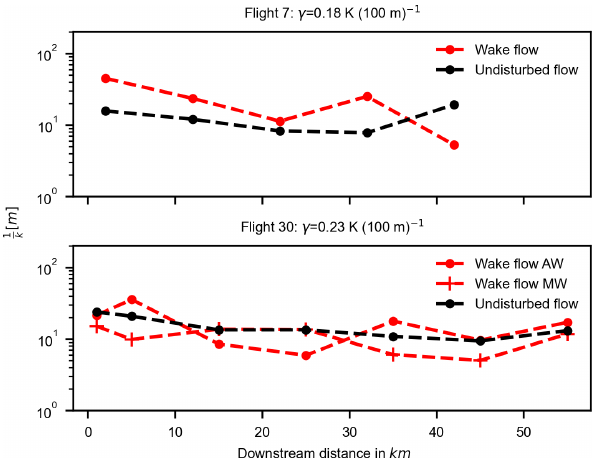
Figure 13. Dominant entrainment length scales in the downstream of the wind farms cluster. These measurements were recorded at hub-height level i.e., 100ma.m.s.l. Note that only five downstream flight legs were recorded for flight 7 and seven flight legs for flight